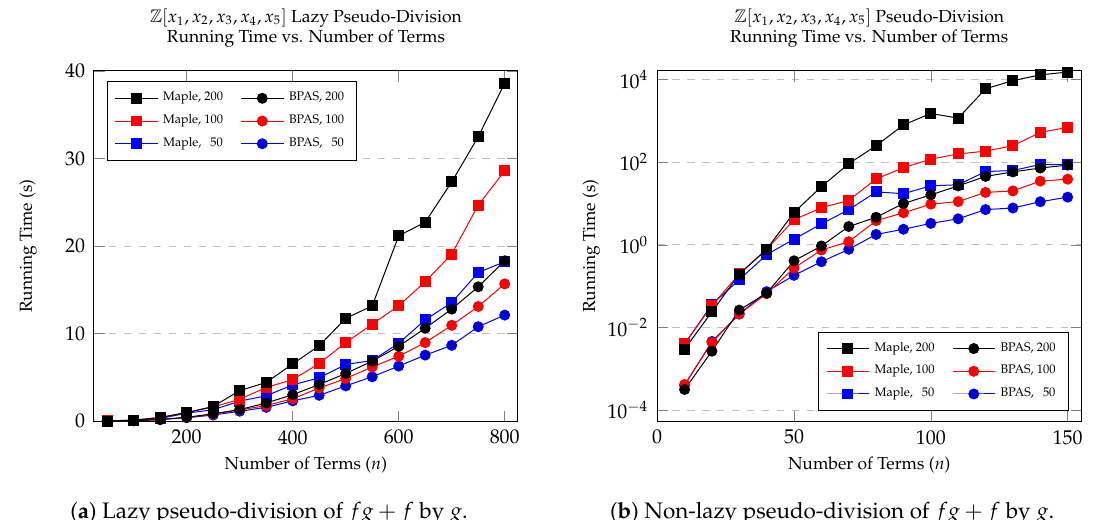
Figure 7. Comparing lazy and non-lazy pseudo-division over Z . Polynomials are in 5 variables and the coefficient bound is 128. The sparsity varies as noted in the